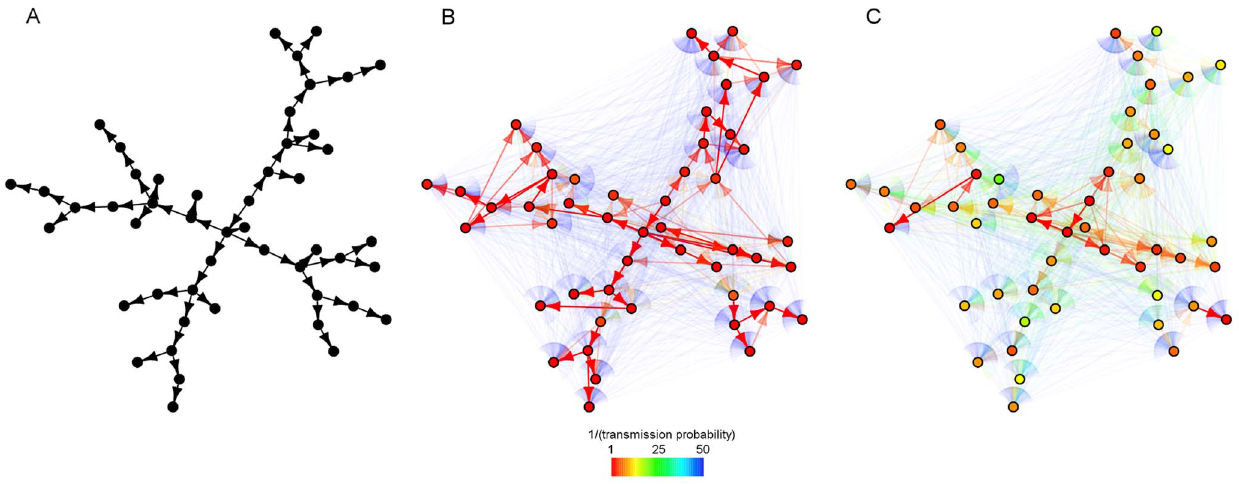
Figure 5. A simulated infection network (A) is estimated using importance factors of v ~ 5 (B) and v ~ 1 (C). The color of edges represents the probability of their existence, while the color of each node represents the highest probability assigned to any its potential sources (thus red indicating near-certainty about the source of a node). Data were simulated with a mutation rate m ~ 1 | 10 { 4 , transmission rate b ~ 1 | 10 { 4 and removal rate c ~ 5 | 10 { 5 .